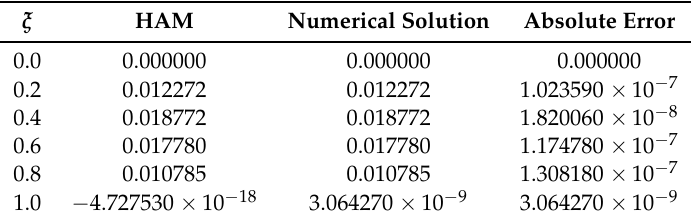
Table 2. Comparision of HAM and Numerical results for f ( ξ ) .